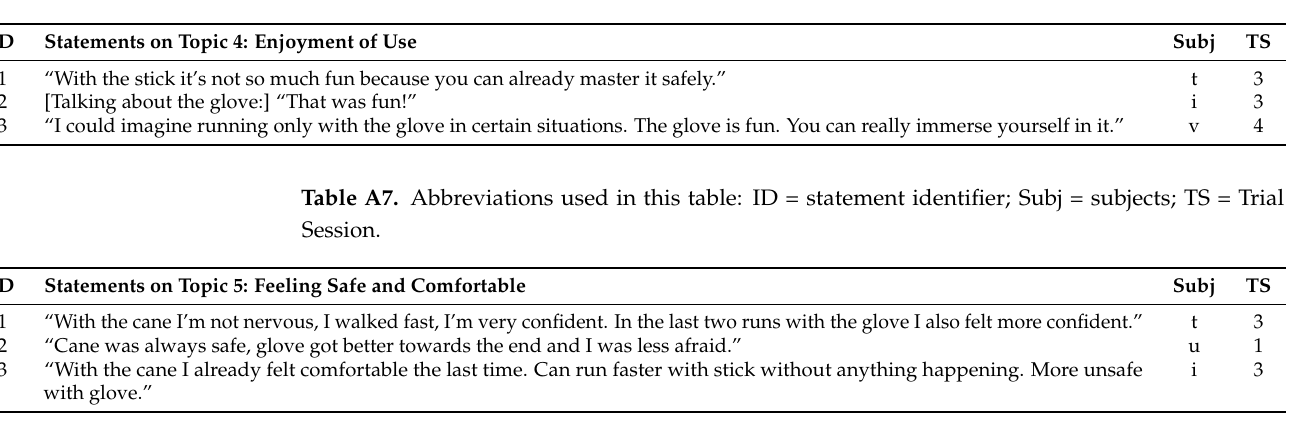
Table A6. Abbreviations used in this table: ID = statement identifier; Subj = subjects; TS = Trial Session.